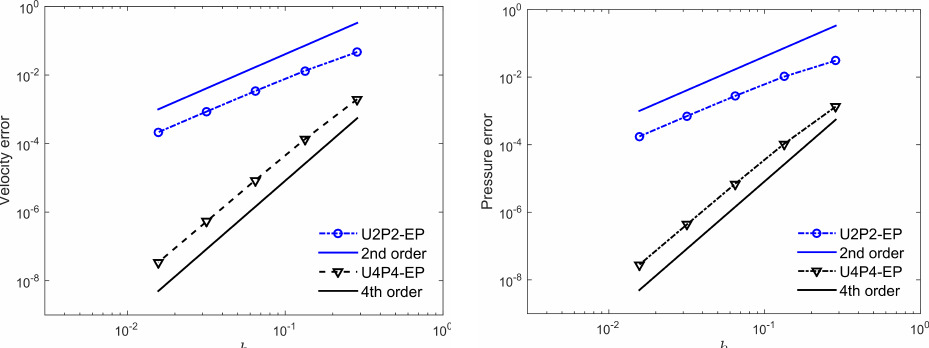
Figure 2. Computation errors ( L ∞ norm) of the Taylor–Green vortices problem. Left: x -velocity error with the spatial discretization size. Right: pressure error with the spatial discretization